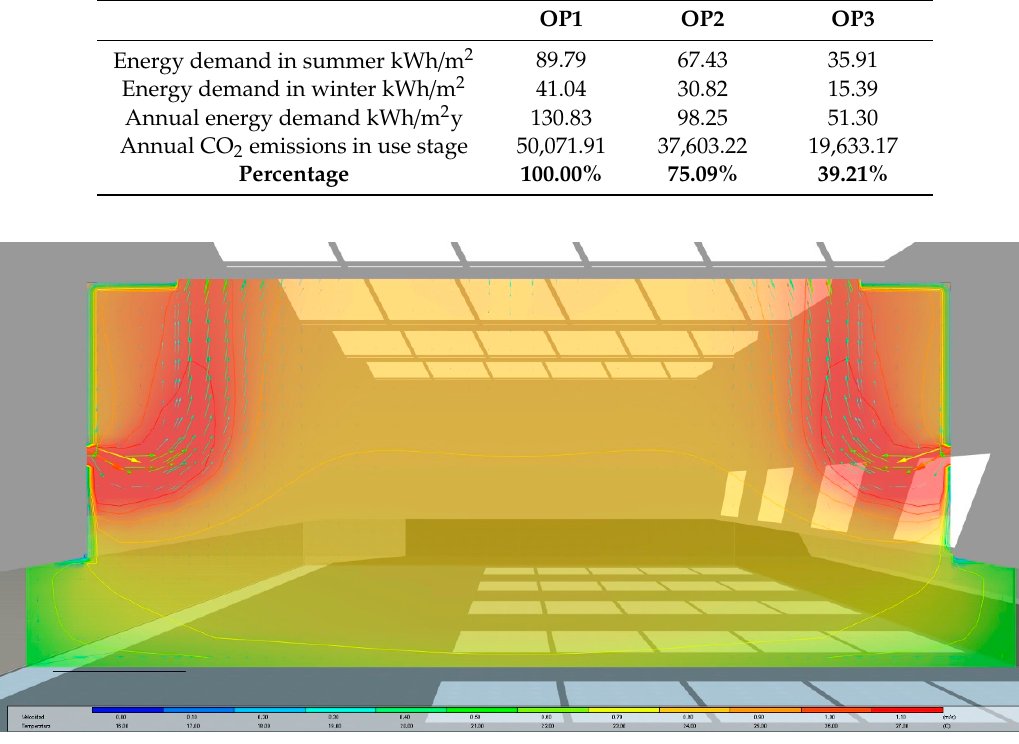
Figure 10. Computational fluid dynamics (CFD) graphic of the existent all-air system. Cross section of the MUA. Indoor air temperatures. 1 February 2015. 9:00 a.m.